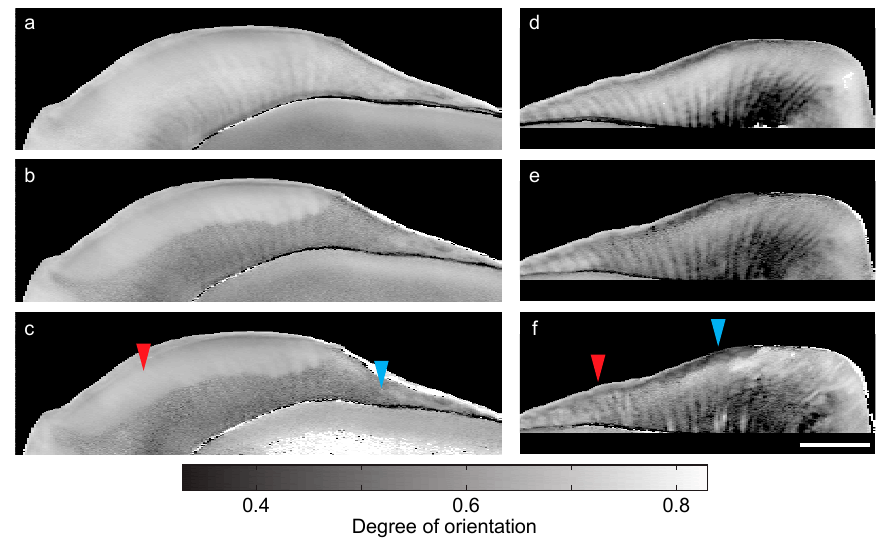
Figure 5. The gray-scale images display the degree of orientation of the scattering patterns for the q -ranges corresponding to the real-space periodicities between 10 and 20 nm ( a , d ), 70 and 80 nm ( b , e ), and 140 and 150 nm ( c , f ) for the natural ( left column ) and the artificial ( right column ) lesions. For the natural lesion the degree of orientation at lower scattering angles, images ( b , c ), is increased (red-colored arrow) compared to the sound enamel (blue-colored arrow), whereas for the artificial lesion regions with higher (red-colored arrow) and lower (blue-colored arrow) anisotropy compared to the sound enamel appear for all length scales investigated. The scale bar corresponds to 1 mm.